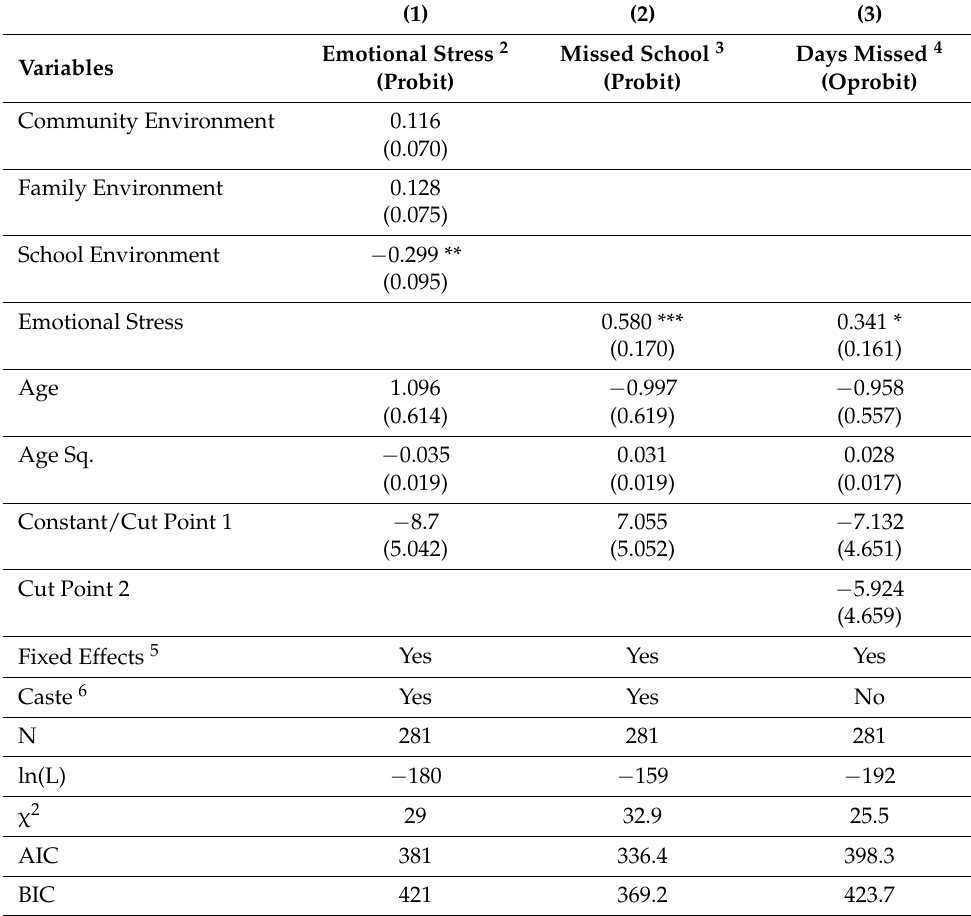
Table 2. Single equation estimation of menstruation-related emotional stress & school absence 1